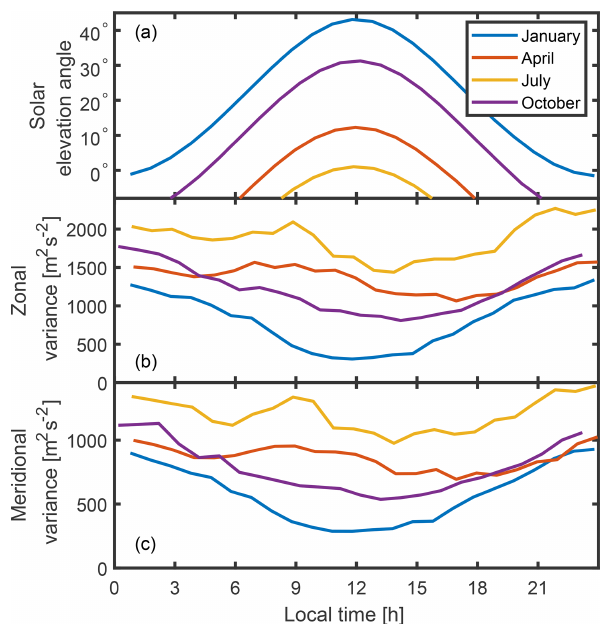
Figure 7. (a) The average solar elevation angle for the 4 months indicated as a function of local time at Rothera; (b) the average daily cycle of zonal variance averaged over range gates from 88.5 to 90.5km for the same months: January (blue), April (red), July (yellow) and October (purple); (c) the same but for meridional vari-